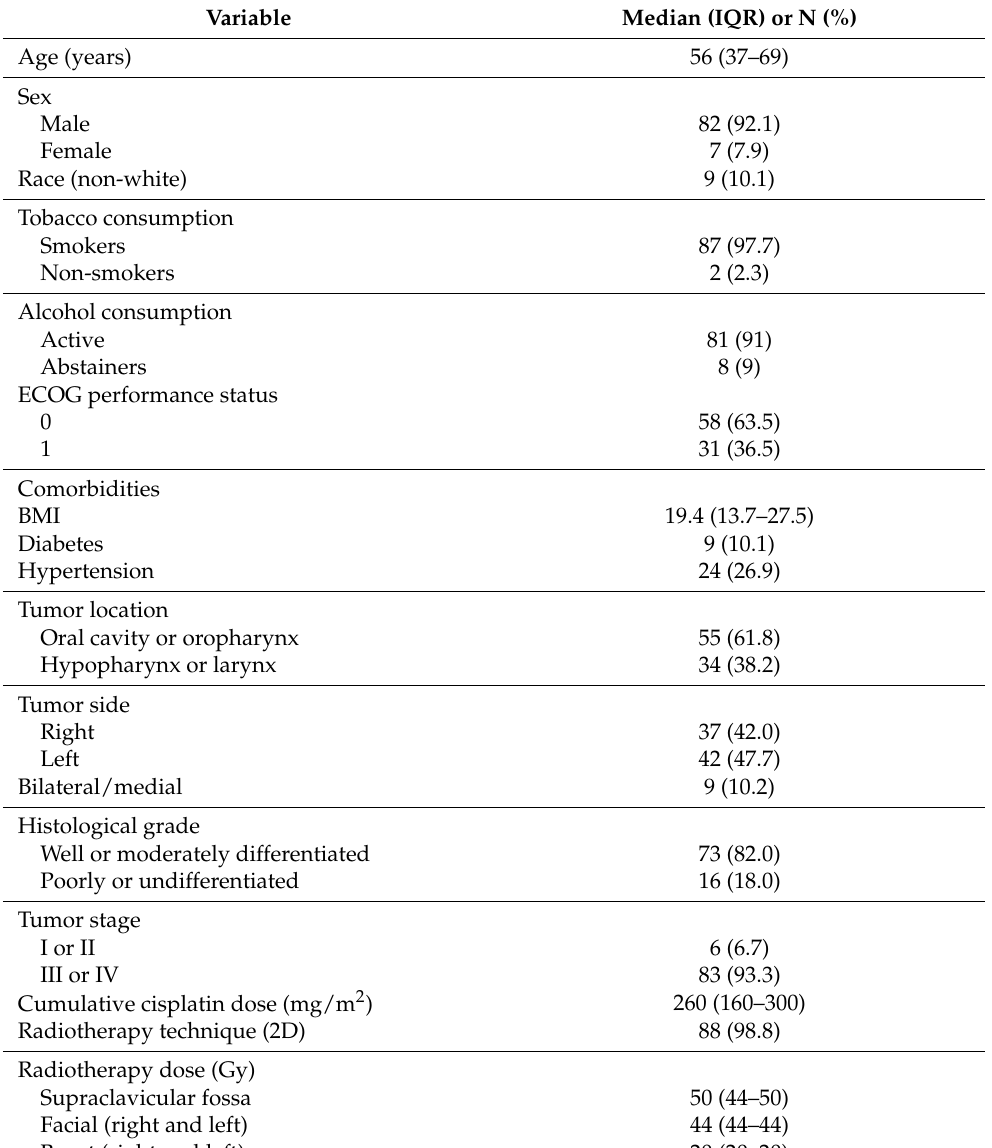
Table 1. Clinical and pathological characteristics of patients included in the